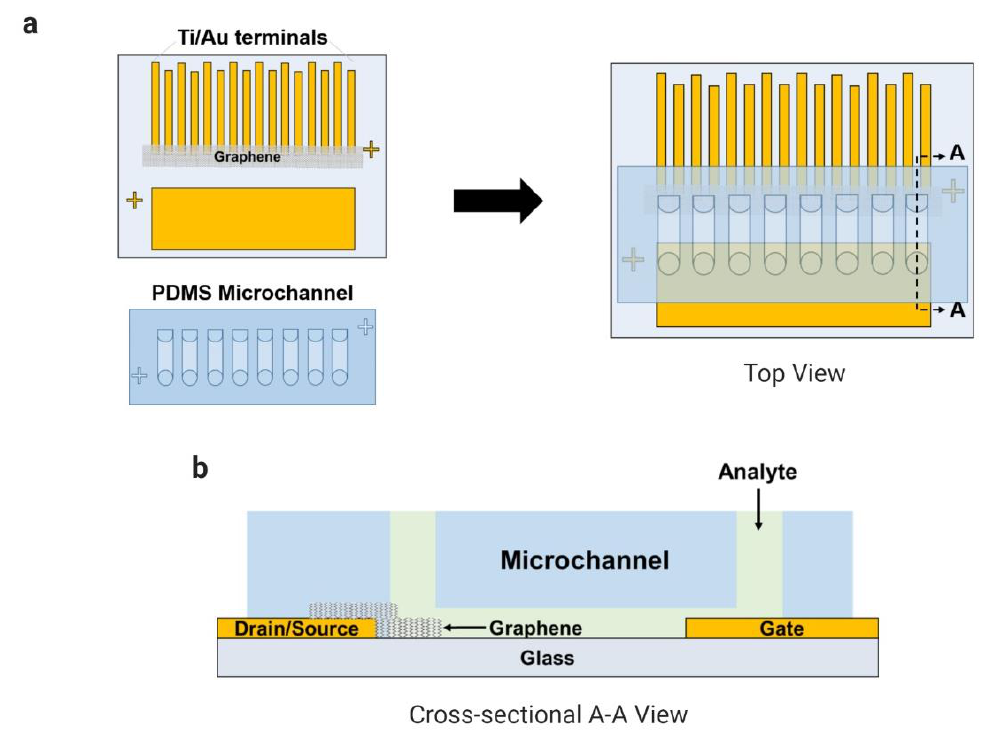
Figure 1. Microchannels integrated with the electrode array (eight pairs) of the common-gate graphene-based field-effect transistor (GFET) sensor to detect L-lactic acid in human samples: ( a ) top view and ( b ) cross-sectional A–A view.